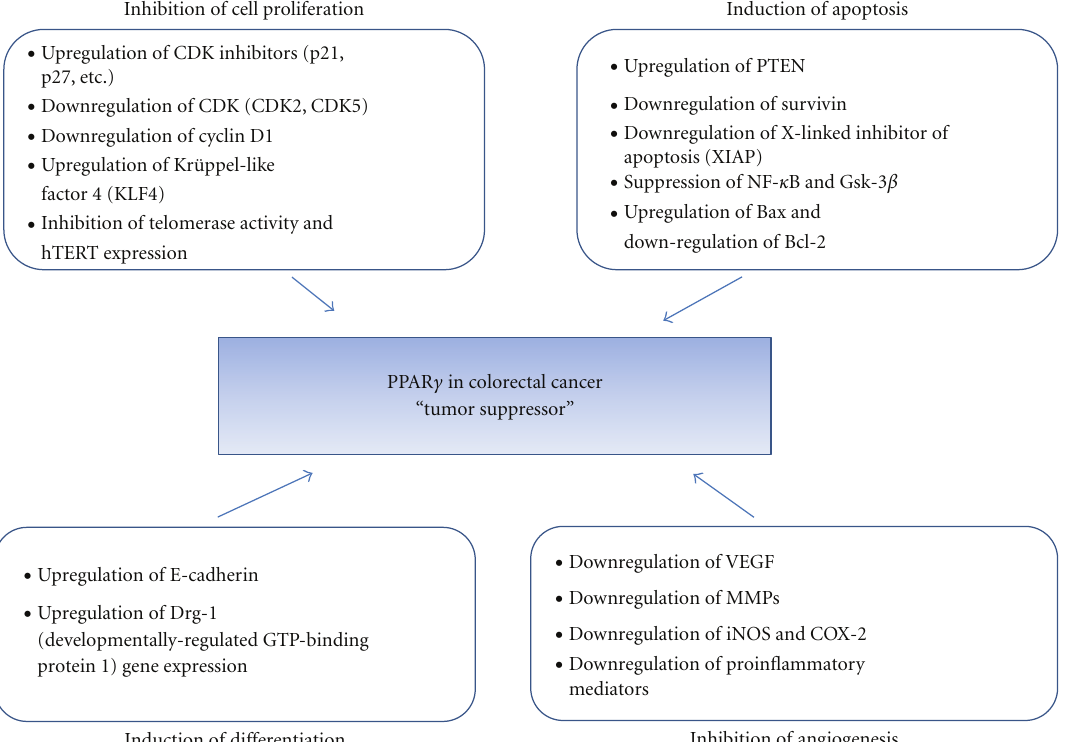
Figure 2: Potential molecular mechanisms for PPAR γ as tumor suppressor in colorectal